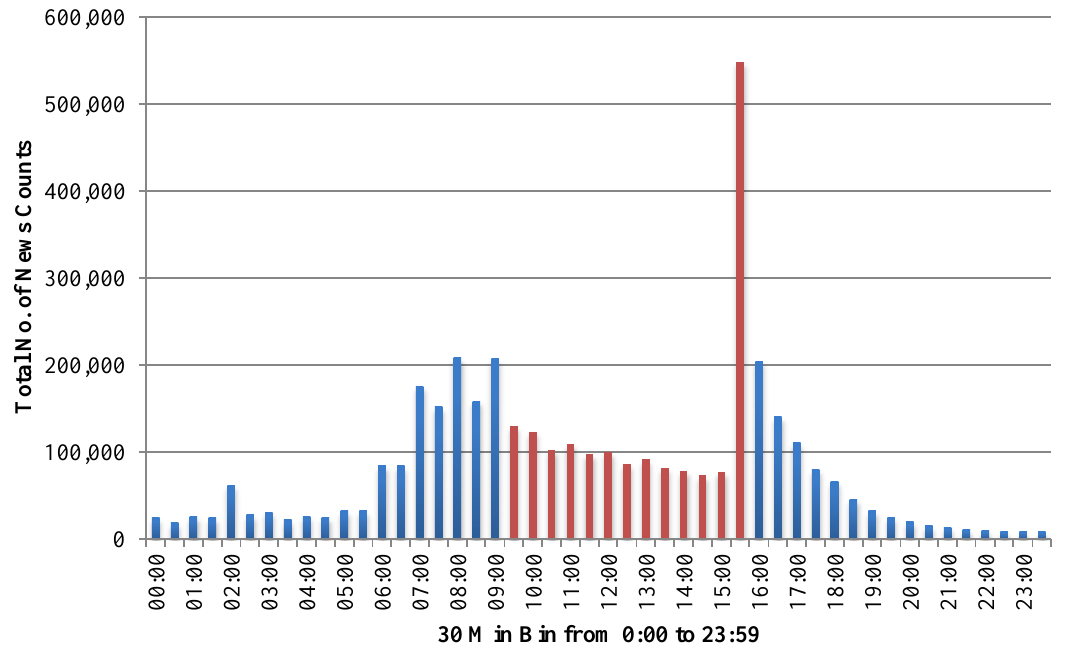
Figure 4. Total number of news stories by time of day. Time interval 0:00 represents 0:00 to 00:29 and interval 23:00 represents 23:00 to 23:29. Trading hours are highlighted in red. Bin 15:30 to 16:00 has the most news